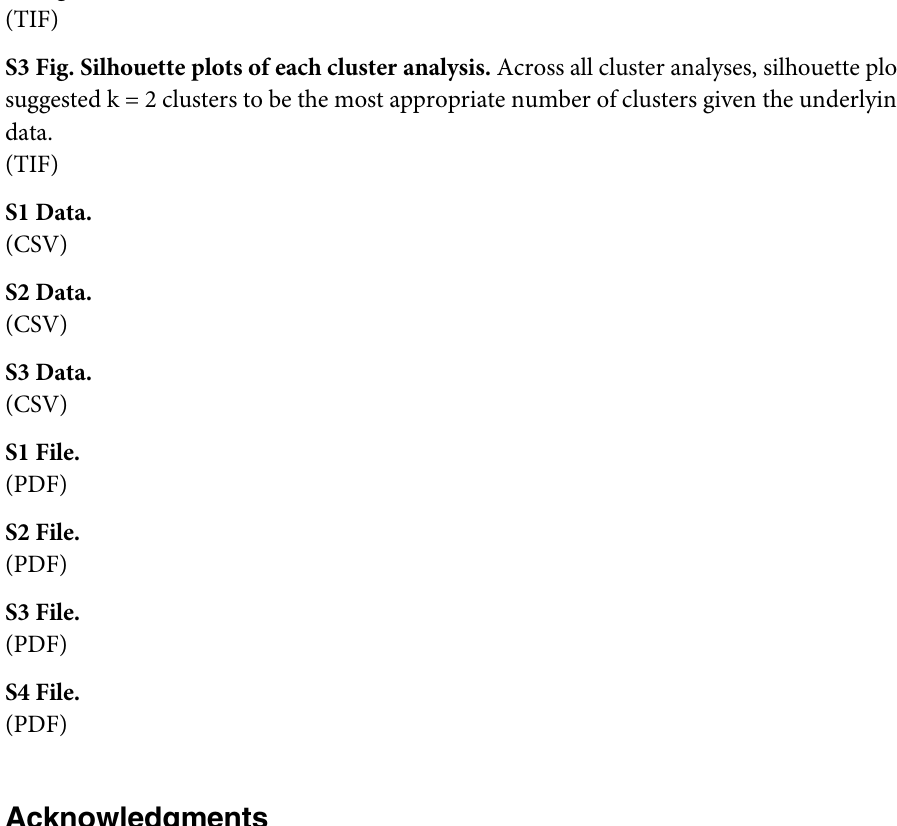
S1 Table. List of R packages. A complete list of implemented R packages in alphabetical order. S1 Fig. Network structure of interrelationships among variables included in the random forest. Input variables of cluster analyses and potential associations with external factors. S2 Fig. ROC curves of the random forests. S3 Fig. Silhouette plots of each cluster analysis. Across all cluster analyses, silhouette plots suggested k = 2 clusters to be the most appropriate number of clusters given the underlying